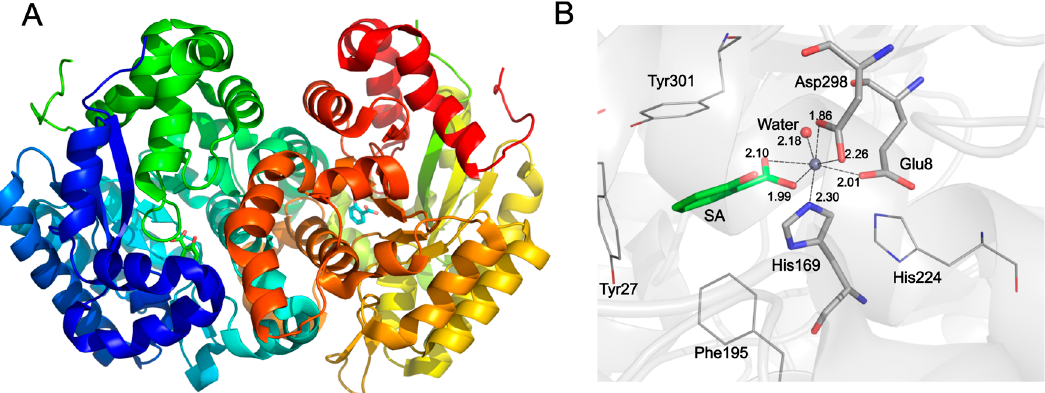
Figure 1. ( A ) Crystal structure and ( B ) active site of salicylic acid decarboxylase (PDB ID: 6JQX).